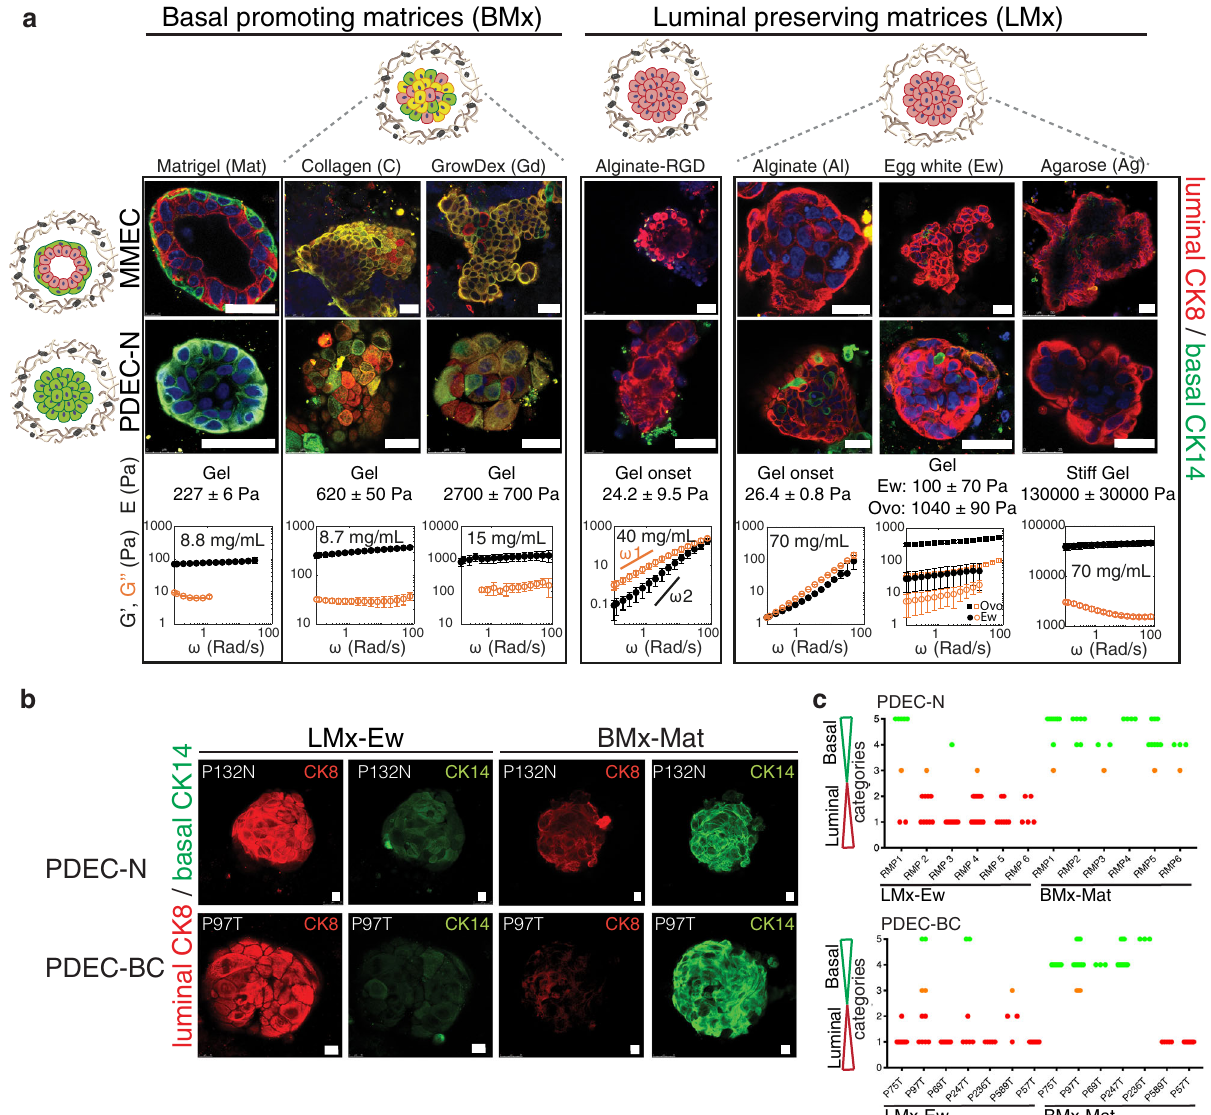
Fig. 2 Matrix de fi nes the epithelial cell identity. a Immuno fl uorescence images of MMECs and PDEC-N stained for CK8 and CK14 after 7 days culture in the indicated matrices. The basal cell identity promoting matrices were named as BMx. These matrices included Matrigel (Mat), collagen (C), and GrowDex (Gd). The luminal cell identity preserving matrices were named as LMx. They included alginate ( + /- RGD peptide), agarose (Ag), and egg white (Ew). Ovo denotes ovomucin, which is the gelling component of egg white. The phenotype of ovomucin grown explant was identical to egg white grown explants. The mechanical properties of the matrices were measured with oscillatory rheology: The storage modulus ( G ´, black fi lled symbol) at different oscillation frequencies ( ω ) describes the elastic, solid-like properties, and the loss modulus ( G ´´, orange open symbol) illustrates the viscous, liquid-like, properties of the material. G ´ and G ´´ together express whether the matrix is an elastic gel or a viscous fl uid when measured as a function of the oscillation frequency. In general, the material is gel, if G ´ > G ´´, and both G ´ and G ´´ are nearly independent of the frequency. If material is viscous fl uid G ´´ > G ´ and it has strong scaling with frequency (at low frequencies G ´~ ω 2 and G ´~ ω 1 ). The 3D matrices used in this study varied from viscous fl uid ( G ´~ 1 Pa) and soft gels ( G ´~ 10 Pa) all to way to stiff gels ( G ´~ 10,000 Pa). The rheological frequency sweeps show that where egg white, and agarose are gels, the alginates are viscous fl uids in PBS. Elastic modulus ( E ) is estimated from complex modulus ( G *), E = 2(1 + υ )G*, with an assumed Poisson ’ s ratio of υ = 0.44. For comparison to the day 0 sample, see Fig. 1c. b Immuno fl uorescence images of PDEC-N and PDEC-BC stained for CK8 and CK14 after culture in LMx-Ew or BMx-Mat (7d). c , Quanti fi cation of the luminal and basal cytokeratins in PDEC-N and PDEC-BC explants. For details regarding the quanti fi cation, see Supplementary Fig. 3c. N = 6 (PDEC-N) and N = 7 (PDEC-BC) independent experiments. All data are presented as mean values + /- SD. Scale bar = 10 μ